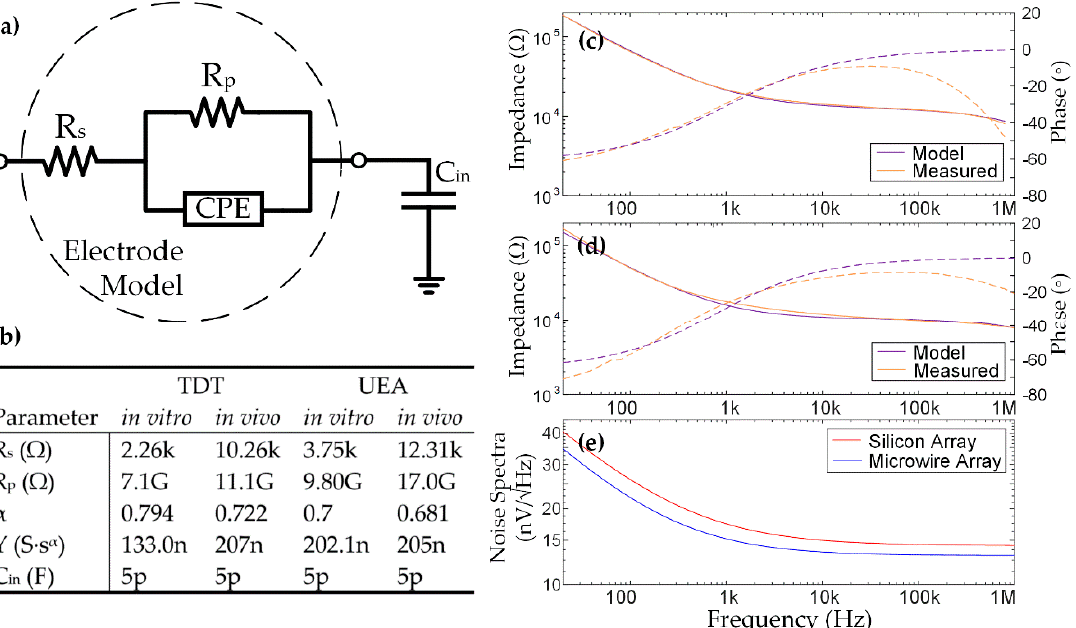
Figure 4. ( a ) Randles equivalent circuit electrode model. R s represents the access resistance, which is the summation of several factors including electrode material, tissue encapsulation, protein binding, and cellular morphology between the recording and reference electrodes [47]. Faradaic reactions are represented by R p , which is also called the charge-transfer resistance and is representative of electrode surface oxidation and reduction reactions [27]. ( b ) Calculated model parameters in vitro and in vivo. ( c ) Measured and modeled in vivo impedance magnitude and phase for the representative silicon microelectrode array. ( d ) Measured and modeled in vivo impedance magnitude and phase for the representative microwire array. ( e ) Model predicted thermal noise neglecting the effect of C in .